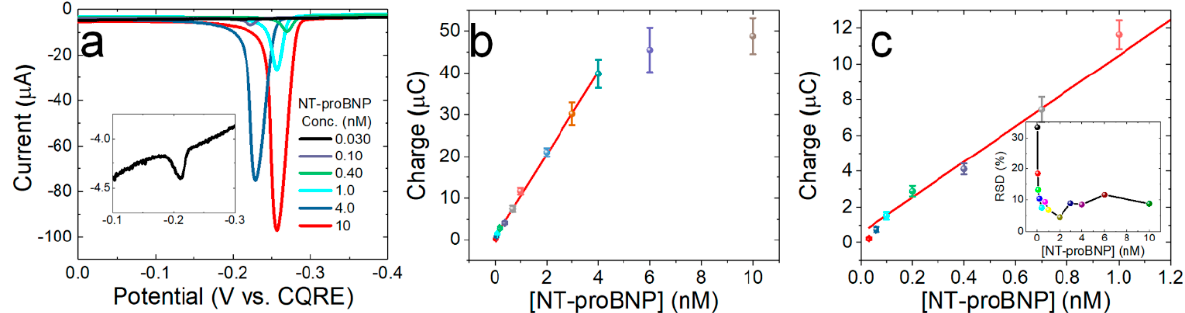
Figure 5. Detection of different concentrations of NT-proBNP using the antigen-specific assay. ( a ) Selected ASVs for the antigen-specific composites formed using the indicated NT-proBNP concentrations. The inset is an expanded view of the ASV for the 30.0 pM NT-proBNP sample. ( b ) Calibration curve covering the entire range tested for NT-proBNP. ( c ) Expanded view showing more clinically relevant range (0.03–1.0 nM) of the calibration curve in ( b ). The error bars represent the standard deviation from the mean for three independent measurements. The corresponding relative standard deviations as a function of NT-proBNP concentration are shown inset.